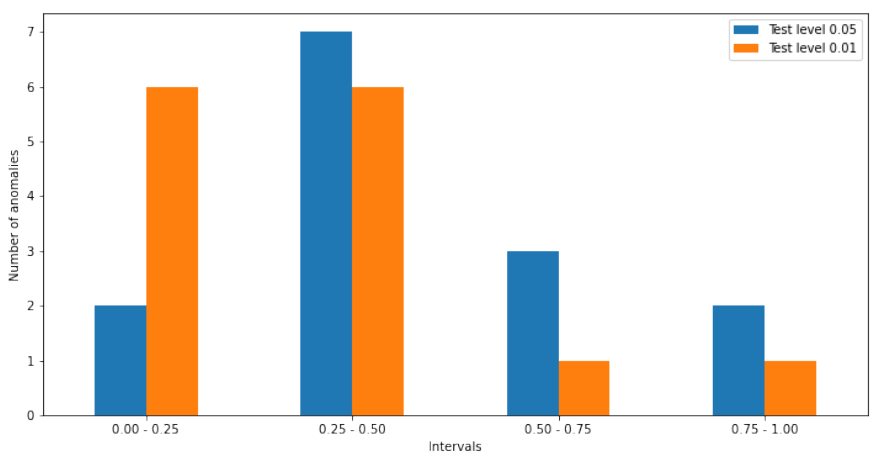
Figure 9. Bar plot of number of anomalies per